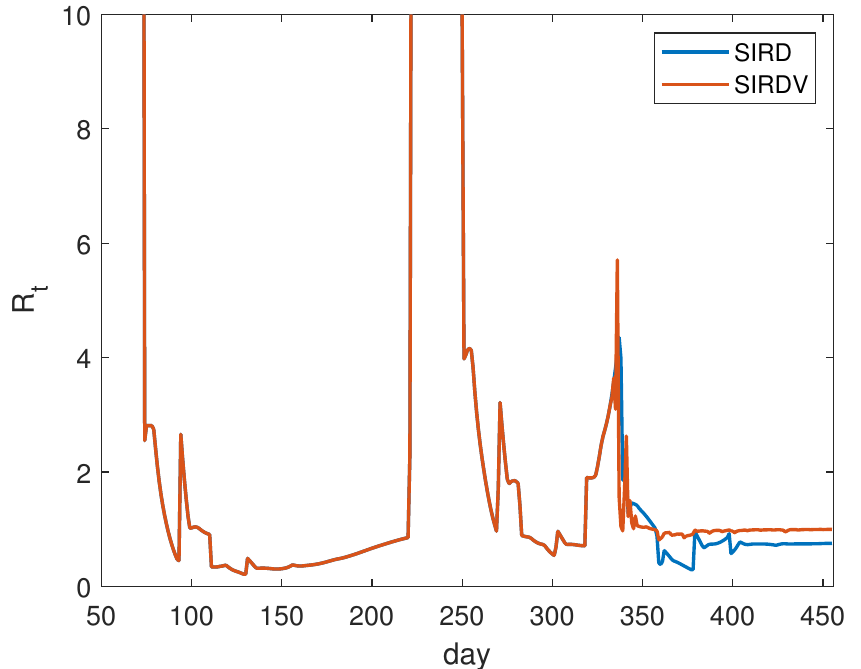
Figure 6. Daily trend of R t for GBR. Both cases of the SIRD and SIRDV models are